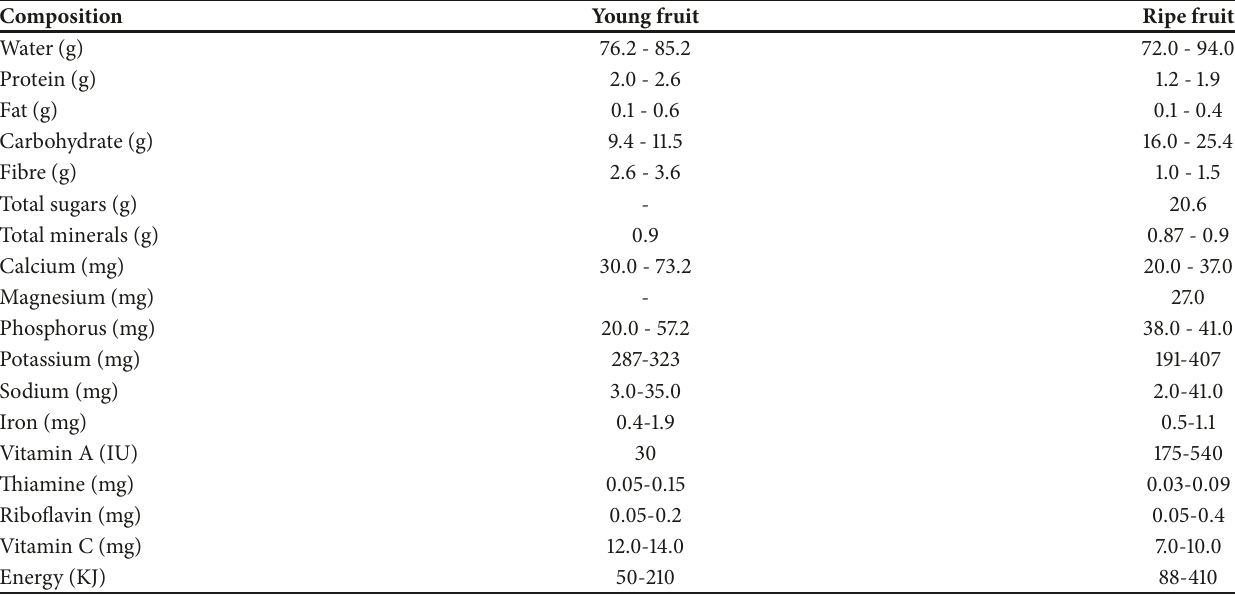
Table 1: Composition of jackfruit (100 g edible